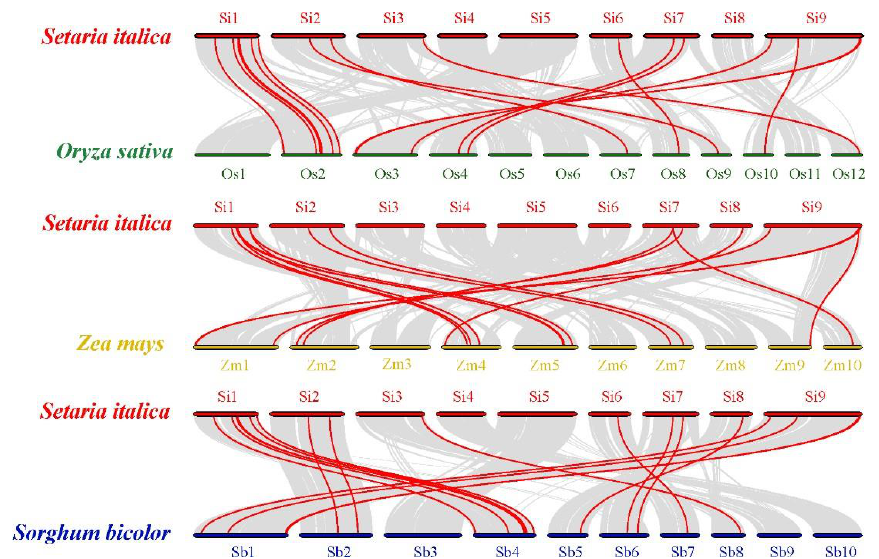
Figure 4. Synteny analysis of remorin genes between millet and three representative monocots. Gray lines in the background represent collinear blocks in the genomes of millet and the other plant species, and red lines highlight collinear remorin gene pairs.